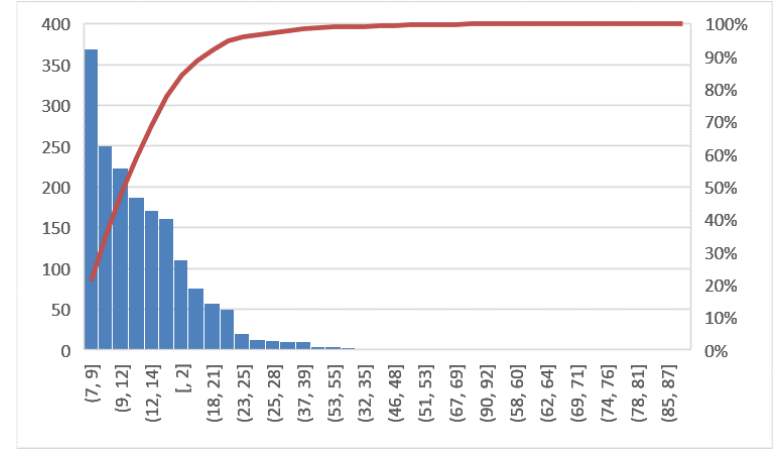
Figure 2. Pareto diagram of LOS (2018, 2019).